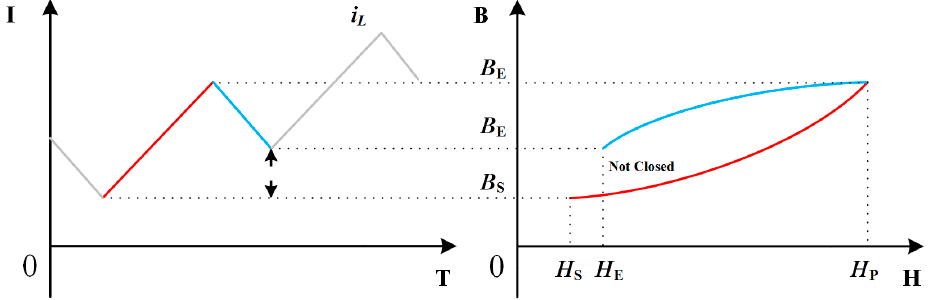
Figure 6. The B-H curve during on switch cycle.